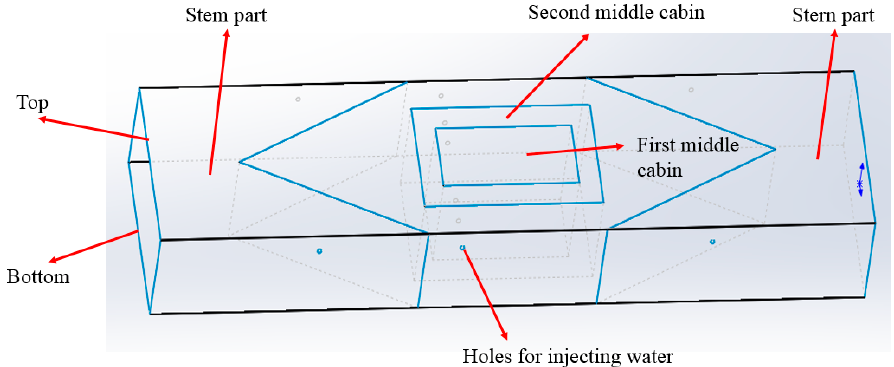
Figure 16. Design drawing of the floating, production, storage, and offloading unit (FPSO) model.